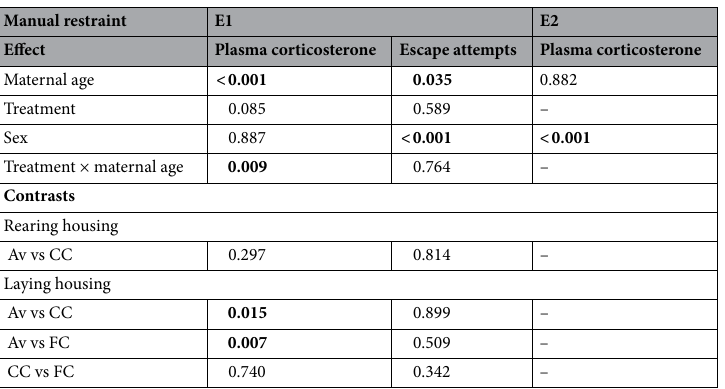
Table 2. Manual restraint test. Effects of maternal age, treatment and treatment by maternal age on plasma corticosterone concentration and escape attempts, followed by contrast comparisons of maternal rearing and laying environments. P-values less than 0.05 are bolded.